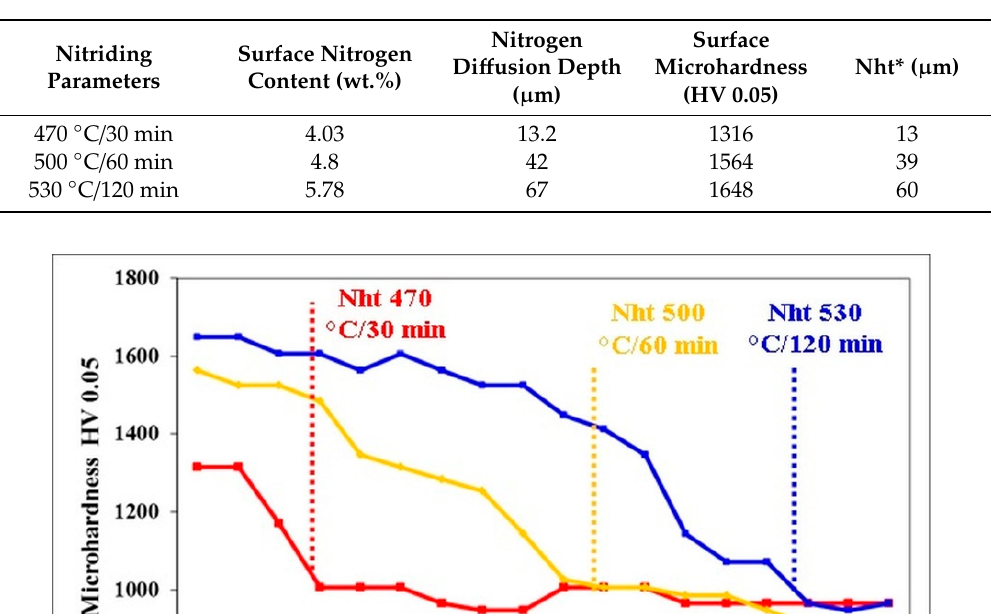
Table 3. Main parameters of nitrided regions (*the nitriding case depth Nht is determined as core hardness + 50 HV0.05).